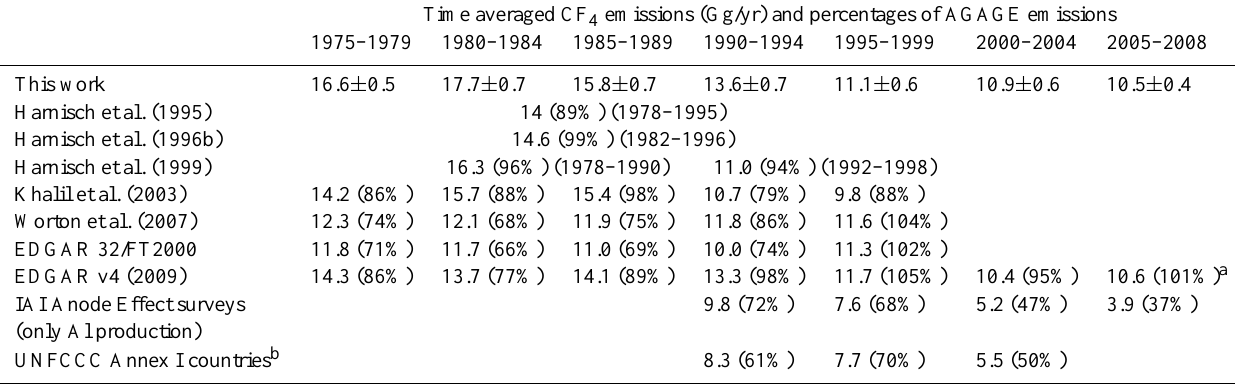
Table 6. Time averaged global CF 4 emission